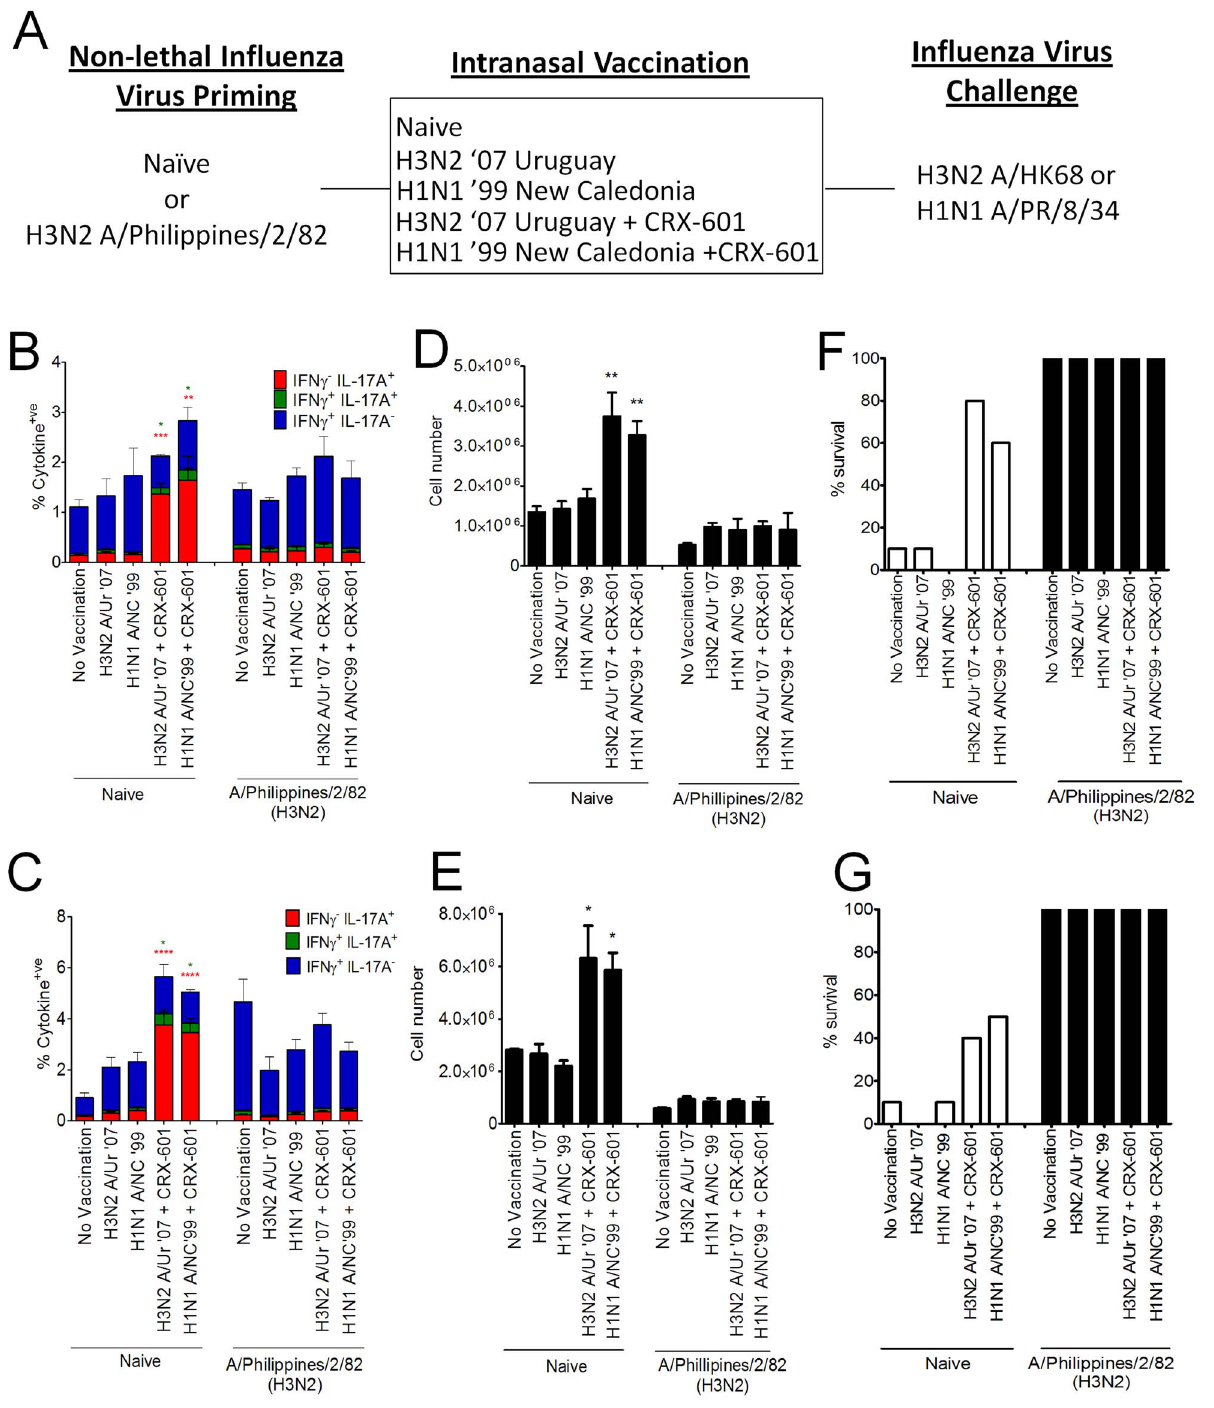
Figure 9. Influenza virus-primed mice maintain a Th1 profile following subsequent intranasal vaccination. Control mice or mice primed with a non-lethal dose of Philippines/2/82/X-79, were subsequently vaccinated intranasally (d28) with split influenza virus antigens derived from either A/Uruguay/716/2007 (H3N2) or A/New Caledonia/20/1999 (H1N1) strains in the presence or absence of CRX-601 liposomes (1 m g/mouse). All groups (10 mice per group) were then challenged with a lethal dose (5LD 50 ) of A/Hong Kong/1968 (H3N2) or A/Puerto Rico/8/1934 (H1N1) (A). Antigen-specific lung T cell responses (B,C) and neutrophil numbers (D,E) were evaluated 5 days post influenza challenge with either A/Hong Kong/ 1968 (H3N2) (B,D) or A/Puerto Rico/8/1934 (H1N1) (C,E). Percent survival for groups challenged with A/Hong Kong/1968 (H3N2) (F) or A/Puerto Rico/ 8/1934 (H1N1) (G) are also shown. * p , 0.05, ** p , 0.01, *** p , 0.001, **** p , 0.0001 are significantly different from no vaccination control (two-way ANOVA, Bonferroni post-test (B,C) and one-way ANOVA, Dunnet post test (D,E).